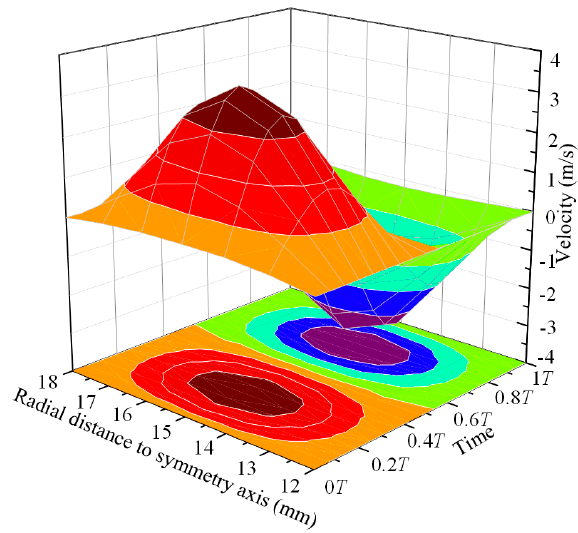
Figure 3. The velocities of the particles in the fluid-solid coupling interface.